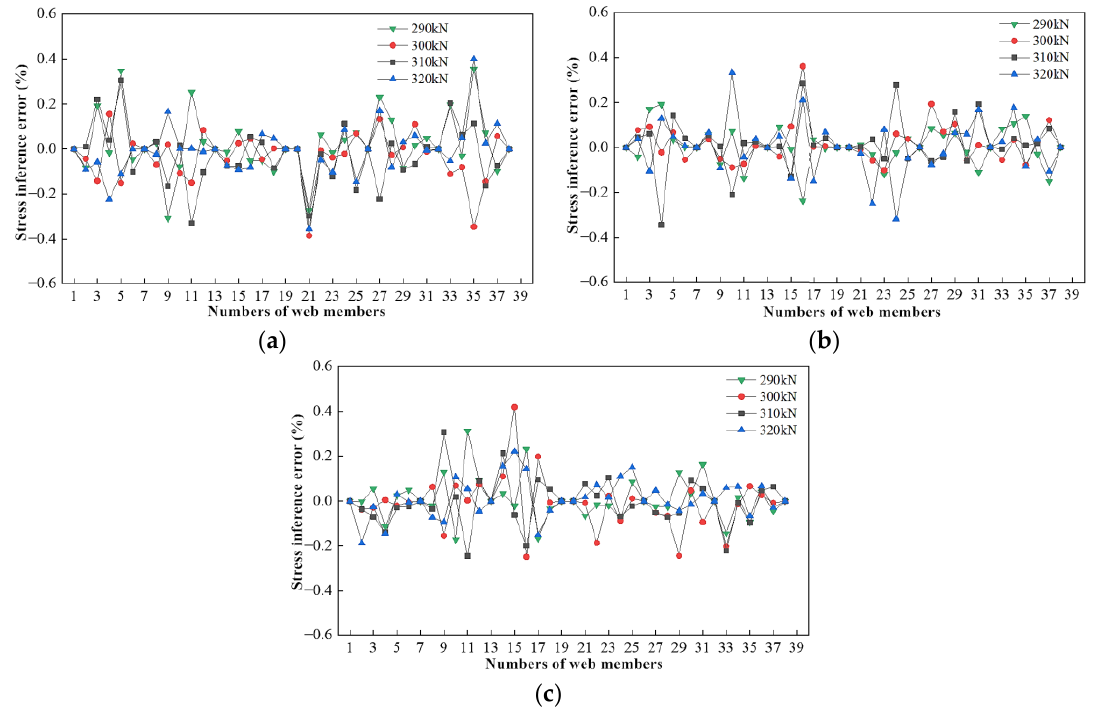
Figure 8. Stress inference error in case 3: ( a ) with the load applied on node 4; ( b ) with the load applied on node 11; ( c ) with the load applied on node 18.